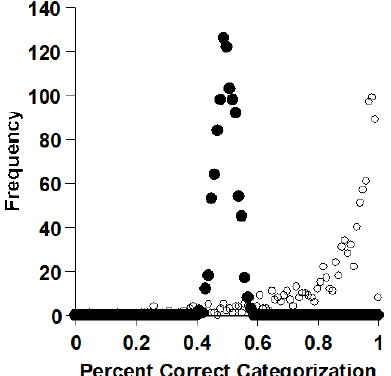
Figure 10. Frequency with which the prototype and exemplar process (filled and open circles, respectively) categorized transfer items at different accuracy levels in an exclusive-or category task.